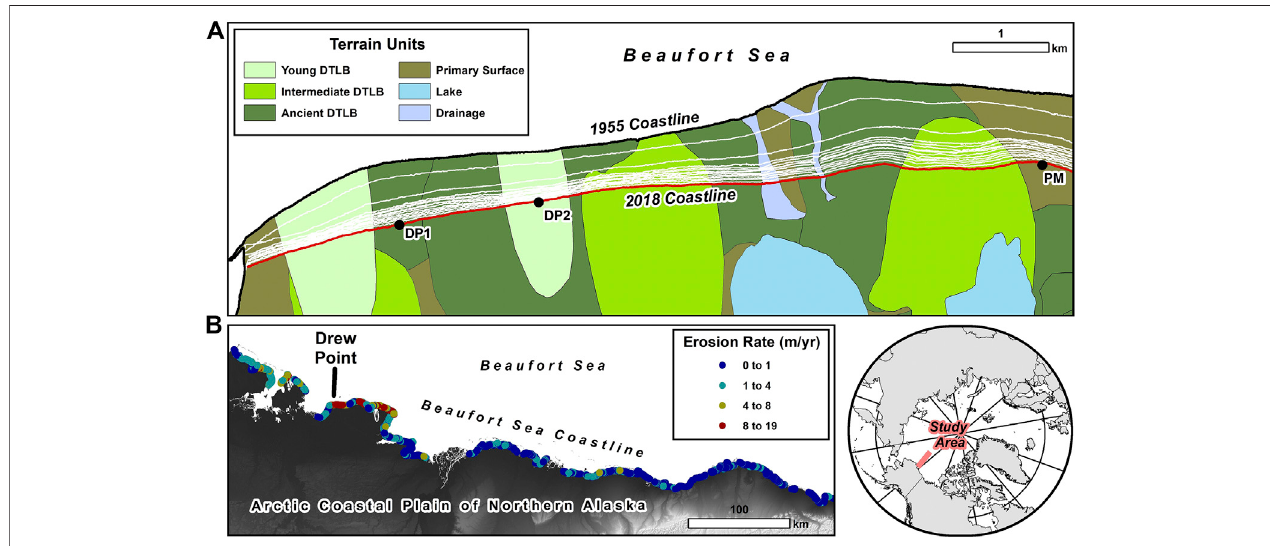
FIGURE 3 | (A) Mapof9 kmstudycoastlinedenotingcoastlinelostfrom1955(boldblackline)and2018(boldredline).Whitelinesshowblufflinepositionfortimesteps between 1955 and 2018.Geomorphicterrain units indicatesurfacewaters, primary materialneverre-worked by thaw lakes,and theage-classi fi cation ofdrainedthermokarst lake basins. Thermokarst lakes were drained throughout the mid-Holocene (ancient) to late- Holocene (young). Coring locations are indicated by PM (primary surface), DP1 (ancientDTLB),and DP2(youngDTLB). (B) MapofAlaskanBeaufortSeacoastwitherosionratesfromcirca1940stocirca2010s(adaptedfromGibbsand Richmond,